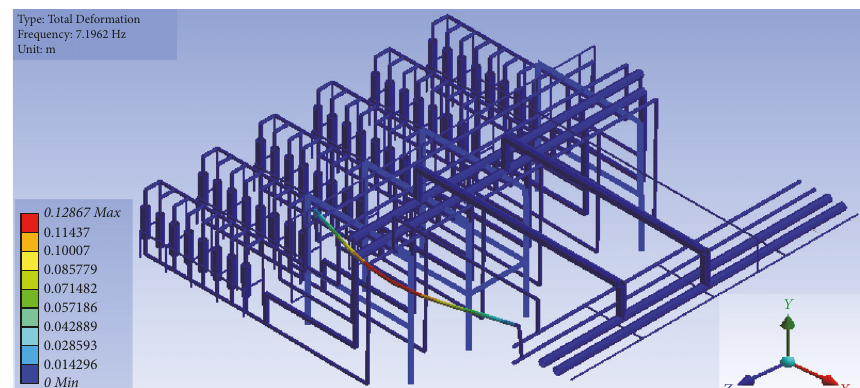
Figure 16: Vibration mode of 1st modal